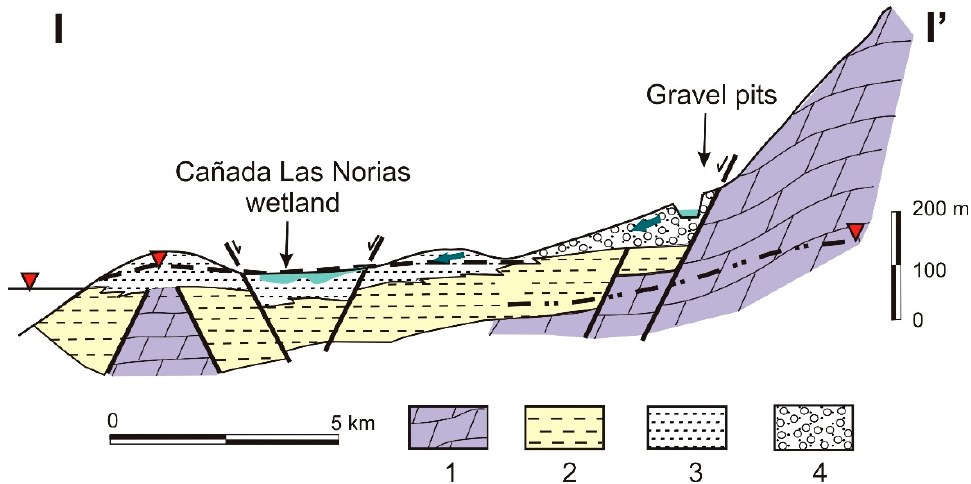
Figure 3. Schematic cross-section. 1: Carbonate deposits (limestone and dolostone); 2: impermeable materials (marl and silt); Pliocene-Quaternary deposits (3: calcarenite; 4: gravel).